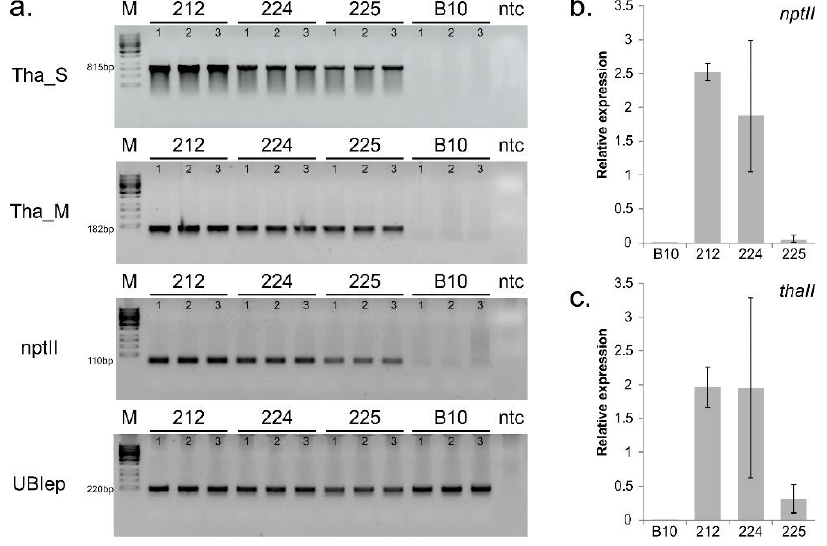
Figure 1. Confirmation of transgenicity. ( a ) PCR amplification of the thaumatin II and nptII transgenes in three transgenic cucumber lines (212, 224, and 225). Lane M: DNA molecular marker; Lanes 1, 2, and 3: individuals of 212, 224, and 225 lines; Lane B10: non-transgenic control plant; Controls: ntc, negative technical control; UBIep, reference gene; ( b , c ) qPCR analysis of mRNA transcripts in fruits of transgenic cucumber plants. Transgenic lines 212, 224, and 225 were compared with the wild-type B10 line; ( b ) expression of nptII , ( c ) expression of thaumatin II .